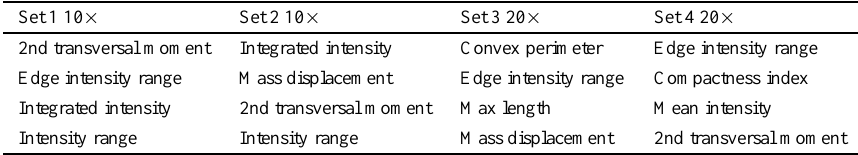
Features selected for different training sets (ordered after